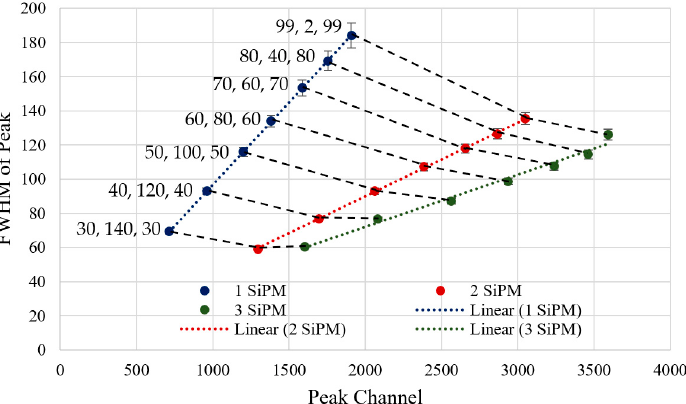
Figure 13. Graph of channel FWHM from each detected peak across all LED testing experiments, with three-sigma error bars. Three lines of best fit consisting of coloured dotted lines have been added on each set of results for 1, 2, and 3 SiPMs, respectively.